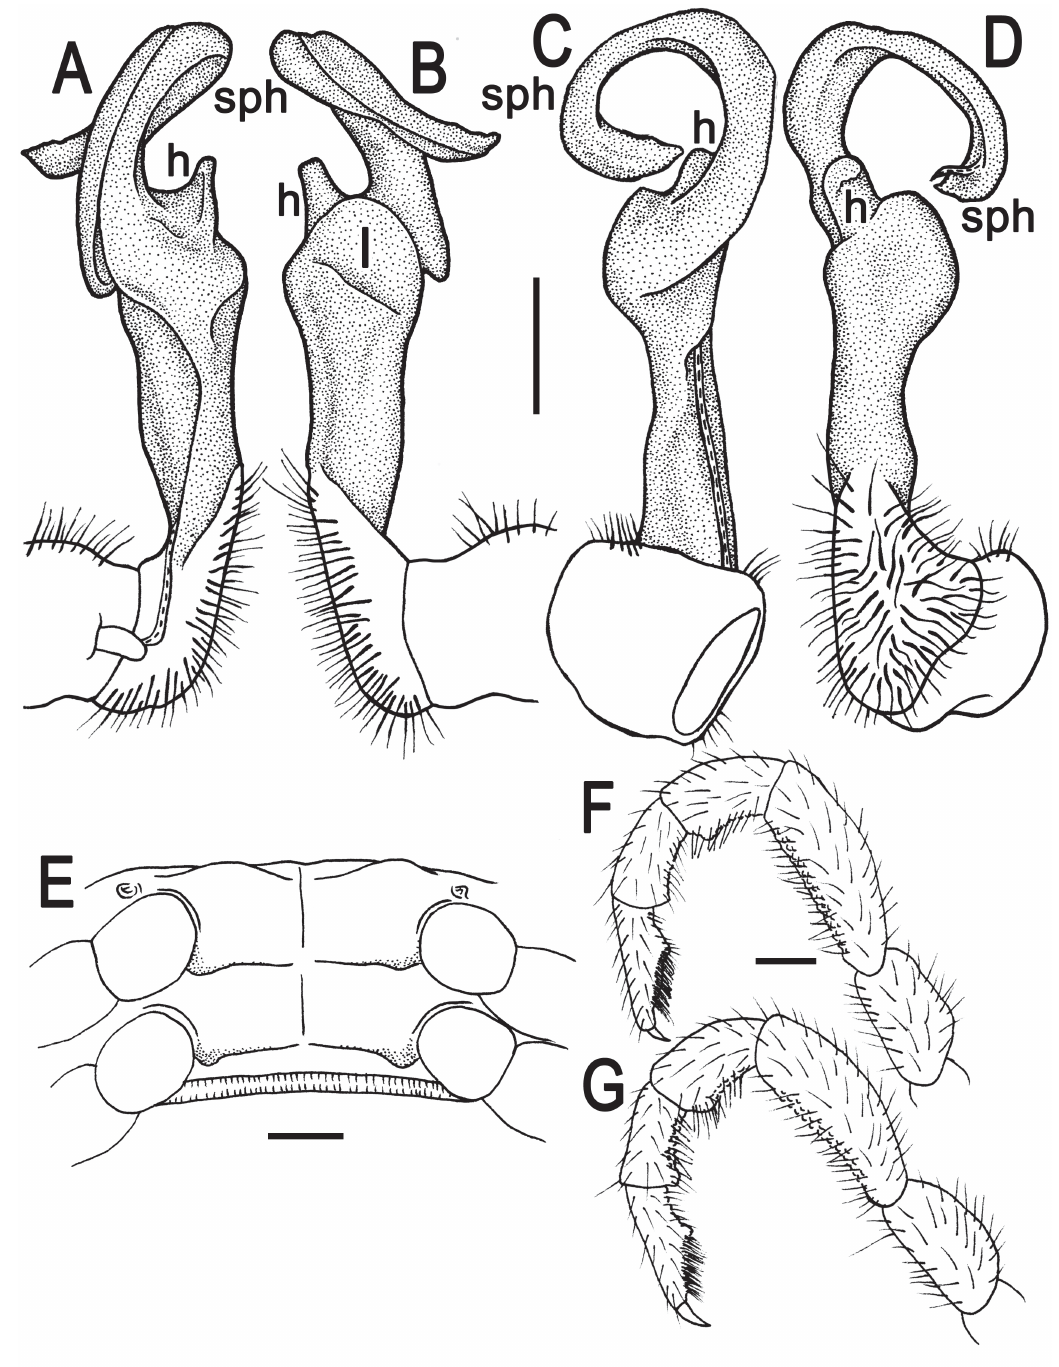
Fig. 11. Tylopus retusus sp. nov., holotype, ♂, left gonopod. A–D . Mesal, lateral, subcaudal and suboral views, respectively. E . Sterna of segment 10. F . Leg 6. G . Leg 10. Scale bars = 0.2 mm. abbreviations are explained in the